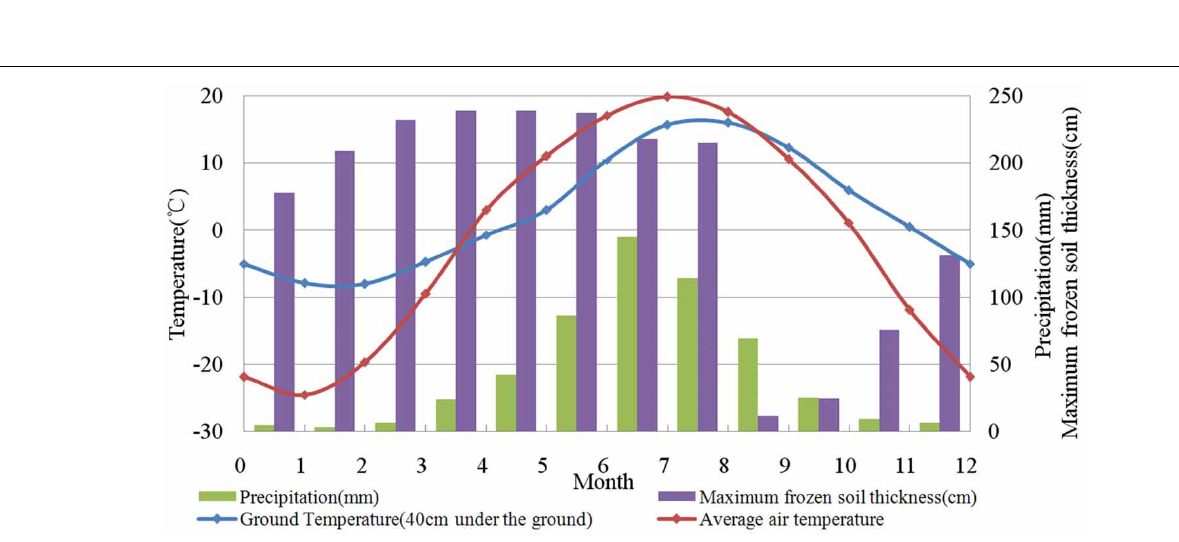
Frontiers in Earth Science | Quaternary Science, Geomorphology and